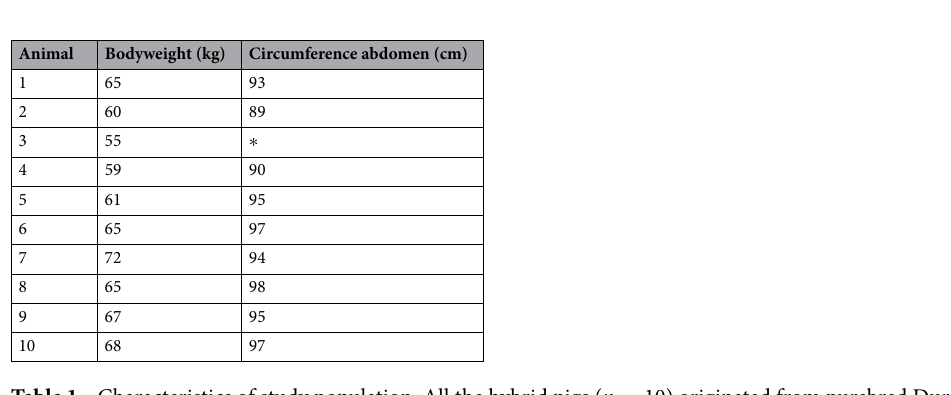
Table 1. Characteristics of study population. All the hybrid pigs ( n = 10 ) originated from purebred Duroc (DD) boars and crossbred Landrace Yorkshire (LY) sows, and were approximately four months old. The asterisk indicates a missing data point (measurement not recorded).